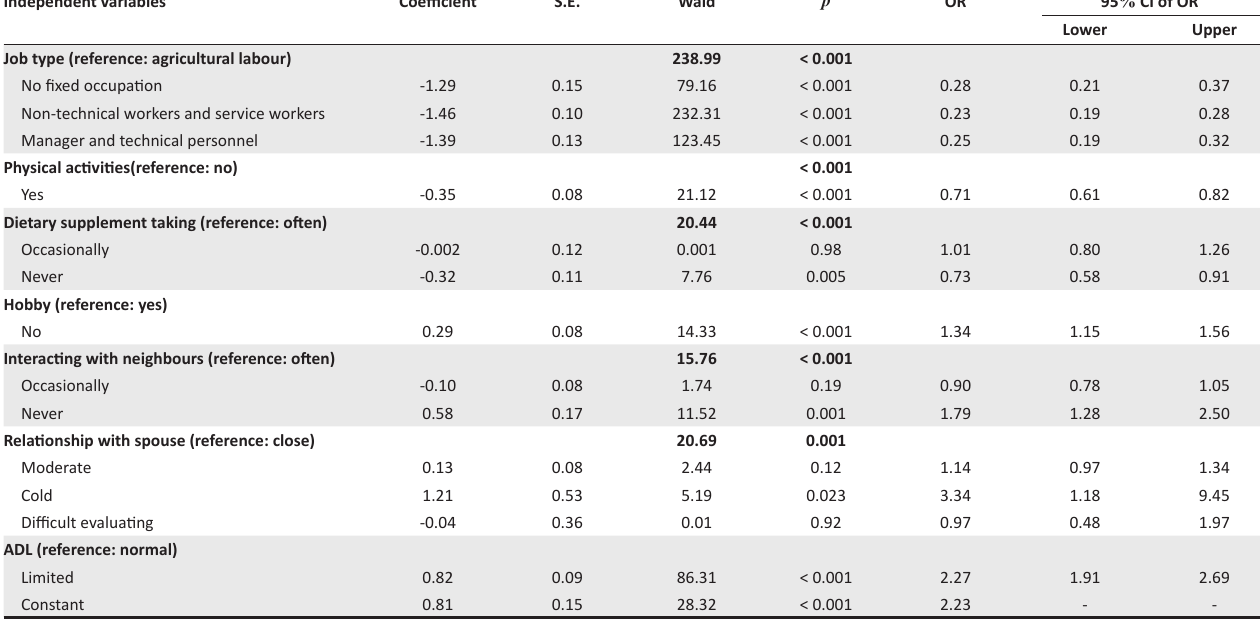
TABLE 5: Logistic regression model of the elderly on depressive